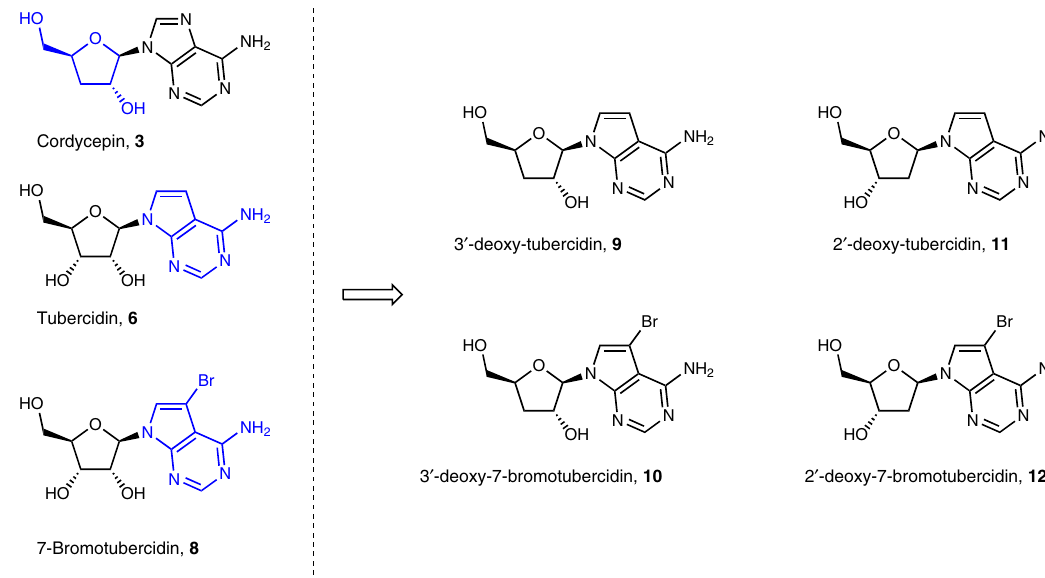
Fig. 2 Combination of cordycepin and tubercidin yields highly potent hybrids (Table 1).